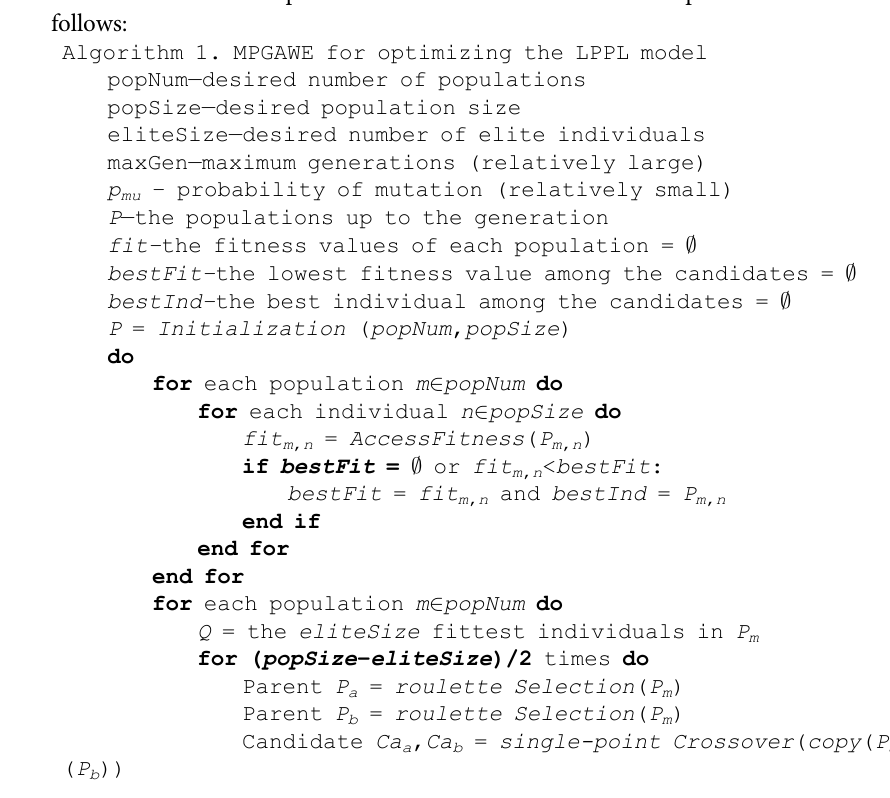
Algorithm 1. MPGAWE for optimizing the LPPL model